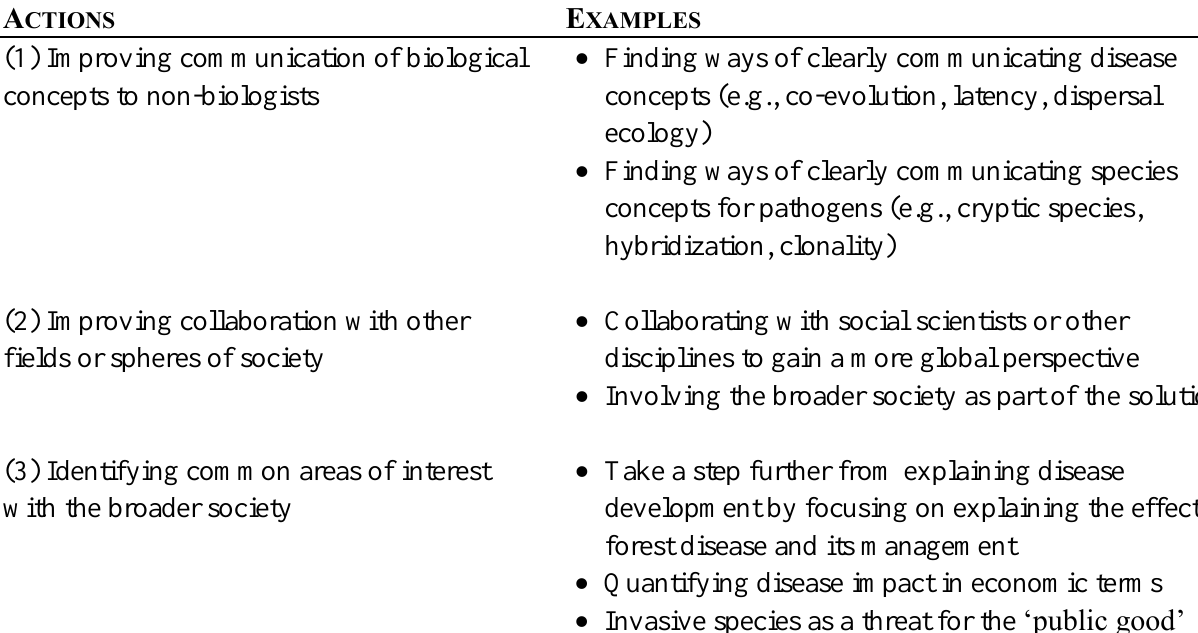
Table 2 . Factors that may help to improve societal understanding and appreciation of the importance of managing forest pathogens and